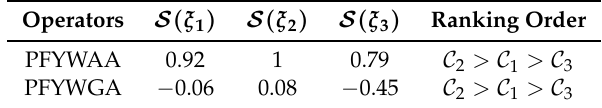
Table 2. Comparison analysis of PFYWAA and PFYWGA operators.